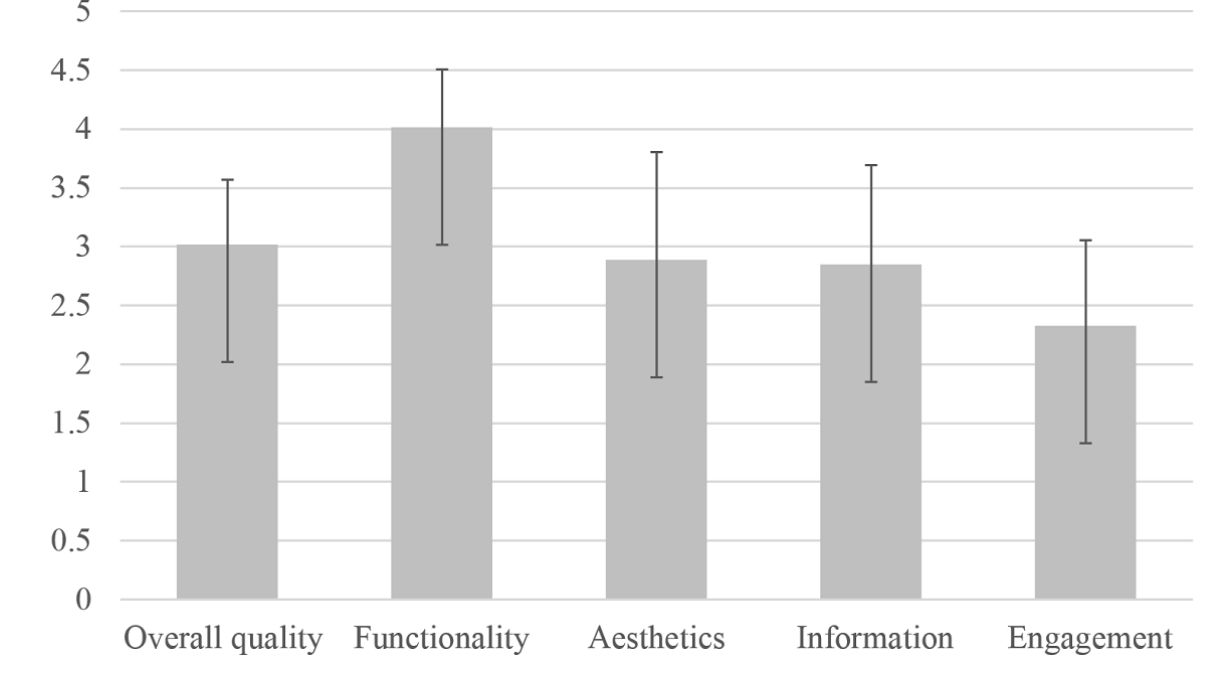
Figure 2. The means and SDs for the overall quality rating and Mobile Application Rating Scale subscales for the included